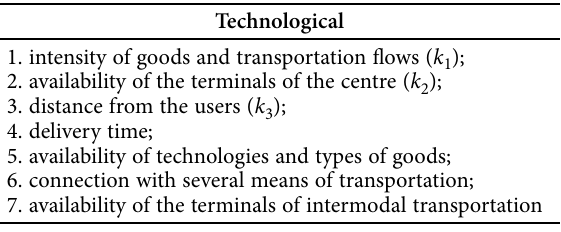
Table 1. Criteria of selection of logistics centre